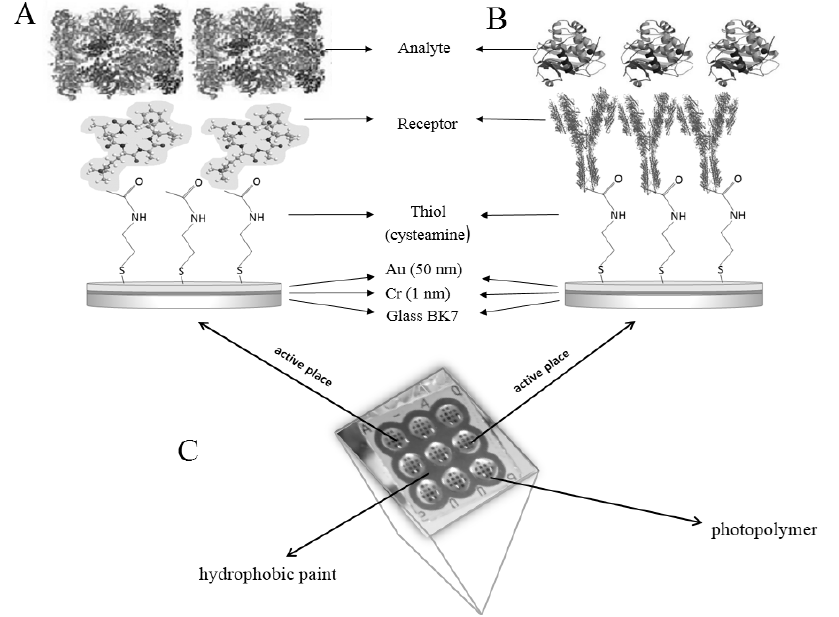
Figure 1. Illustration of the biosensors. Scheme of the active part of the biosensor for 20S proteasome ( A ) and UCH-L1 ( B ). Picture of the chip on the prism ( C ).